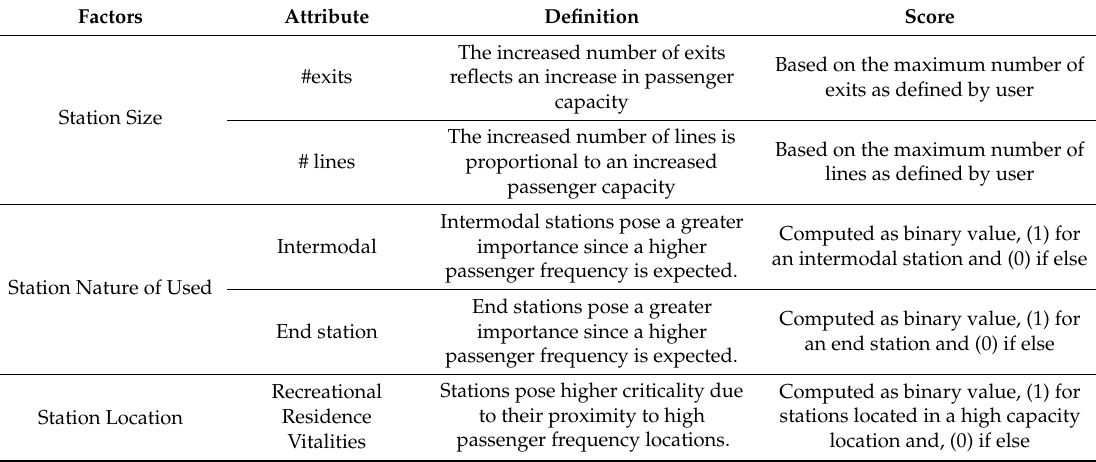
Table 10. Criticality Attributes Definition and Scores